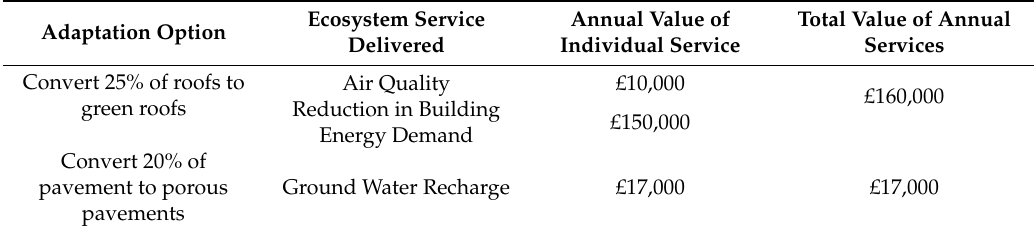
Table 3. The value delivered by potential ecosystem